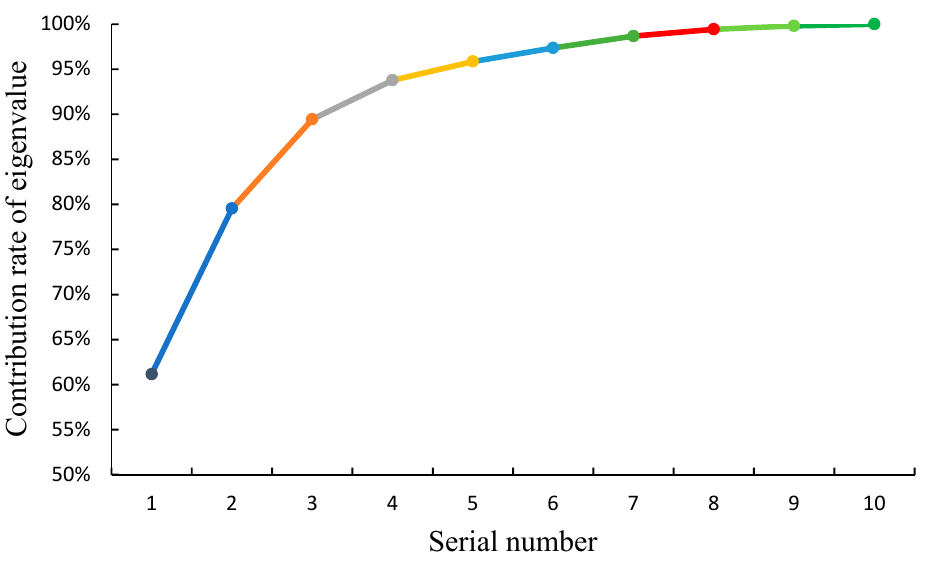
Figure 5. Distributions of the 10 largest eigenvalues.